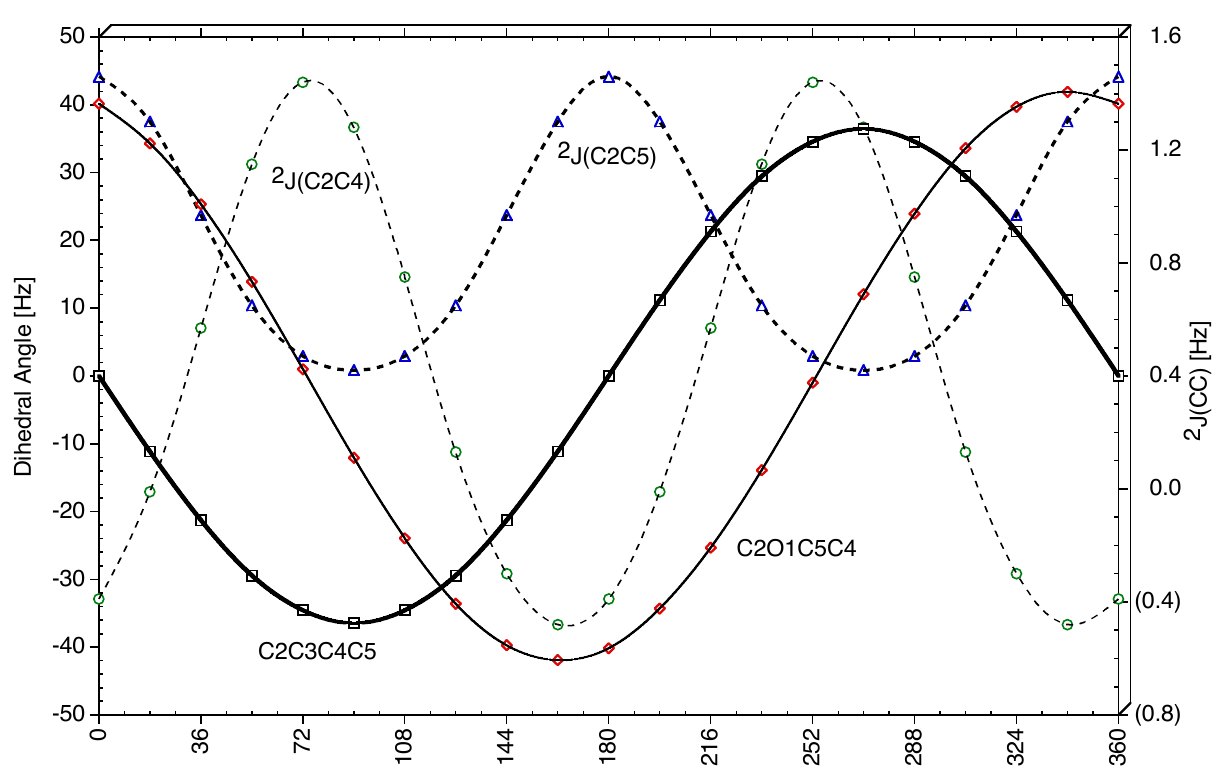
Figure 7: Calculated SSCCs 2 J(CXC) (X = O or C) as a function of the pseudorotational phase angle φ (dashed lines). Also shown is the relationship of SSCCs 2 J(CXC) to a possible three- bond coupling path by giving the dihedral angles associated to this path also as a function of the pseudorotational phase angle φ (solid lines). In this way, 2 J(C2O1C5) is associated with dihedral angle τ (C2C3C4C5) and 2 J(C2C3C4) with dihedral angle τ (C2O1C5C4). The more the dihedral angle deviates from 0 ◦ , the smaller the SSCCs